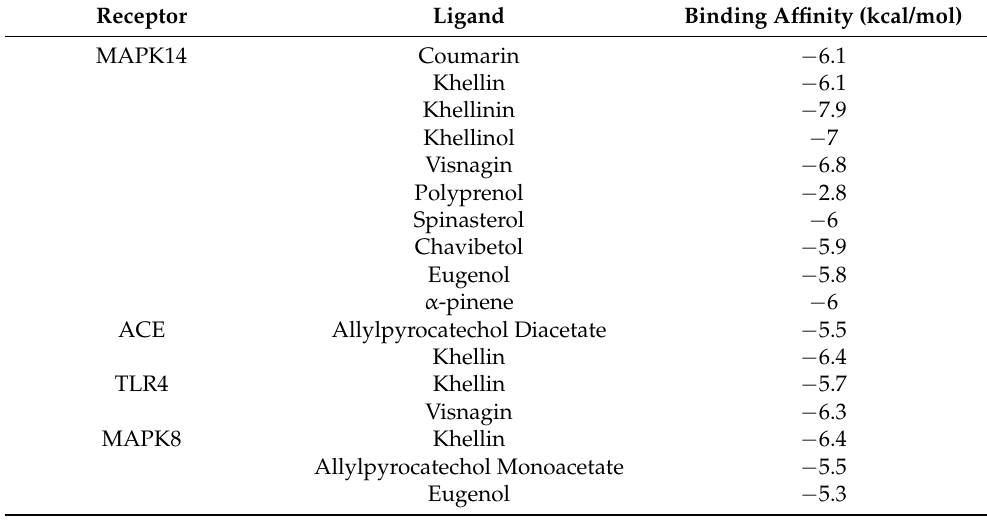
Figure 11. Molecular docking analysis: three-dimensional (3D) representation of interaction patterns of potentially bioactive compounds and COVID-19-associated MAPK14, ACE, TLR4, MAPK8 genes. Table 4. The binding affinity of compounds docked against human target